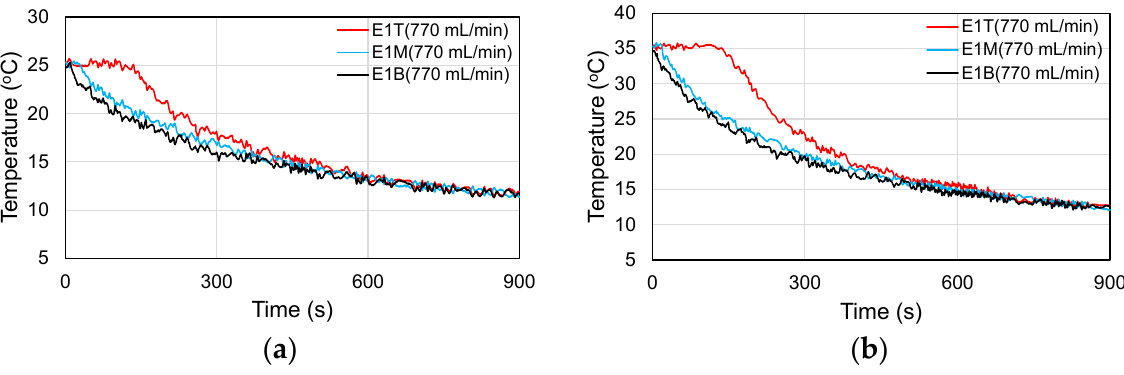
Figure 3. Temperatures variation comparisons between E1T, E1M, and E1B under the flow rate of 770 mL/min: ( a ) the initial temperature of 25 °C; ( b ) the initial temperature of 35 °C. Moreover, the temperature variation trends at other locations are similar to E1, in addition to C2, A1, A3, and C3T. The temperature drops faster in each layer of C2, and there is no hysteresis in the temperature drop in the top layer because C2 is located directly below the feed nozzle. The temperatures of A1B and A3B located in the corner of the acrylic box decrease slower than A1M and A3M. Compared with C1T, C3T has a faster response with a shorter dead time because the location is very close to the drain nozzle. The typical temperature variation comparisons between different flow rates of 770 and 850 mL/min at the initial temperature of 35 ◦ C are shown in Figure 4. There is no difference in temperature responses between different flow rates in the middle and bottom layers. However, in the top layer, the temperature at the flow rate of 850 mL/min decreases faster with a shorter dead time compared with 770 mL/min. The decrease in dead time is caused by enhanced fluid transport at the increased flow rate [24]. These phenomena are also observed using the initial temperature of 25 ◦ C.